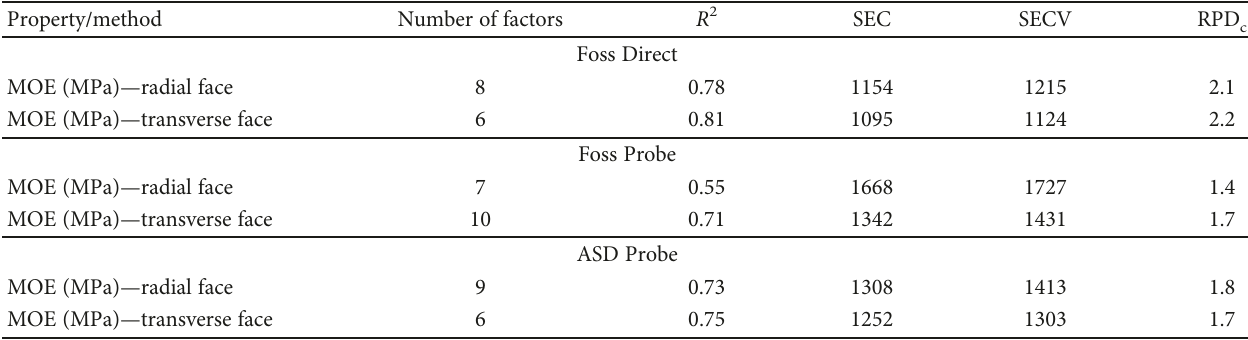
Table 6: Summary of modulus of elasticity (MOE) calibrations based on radial and transverse face NIR spectra obtained using three di ff erent methods (Foss Direct, Foss Probe, and ASD Probe) for collecting spectral data. 334 samples were used to develop the calibrations.